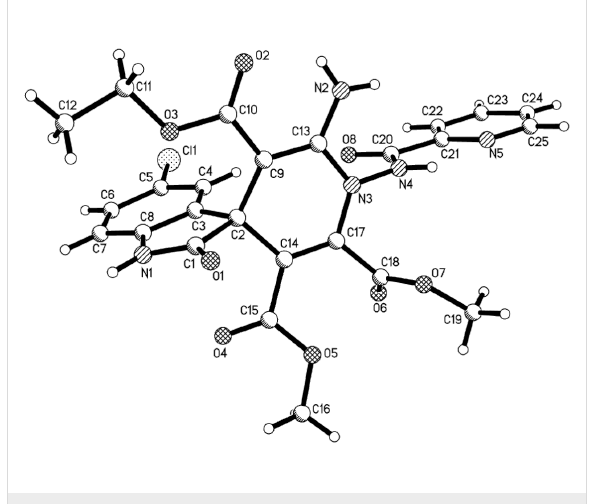
Figure 1: Molecular structure of spiro[indoline-3,4'-pyridine] 1k